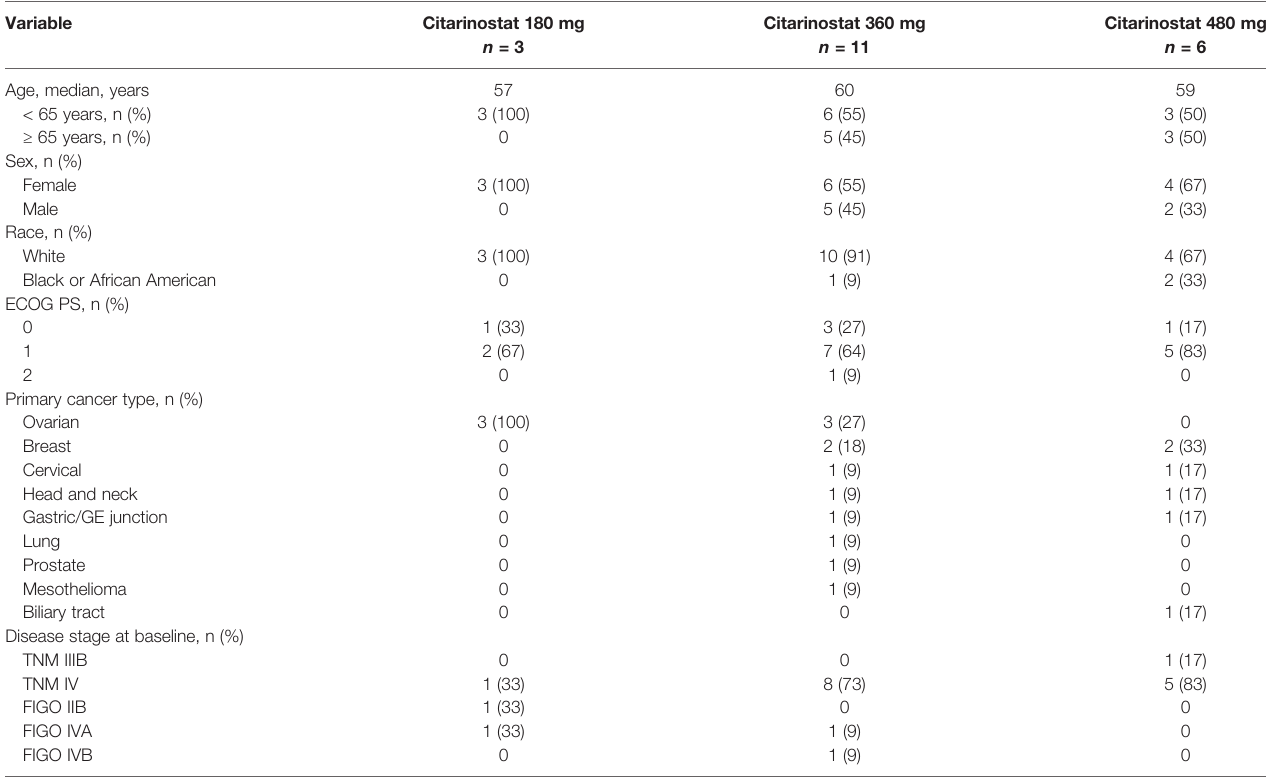
TABLE 2 | Patient demographics and baseline characteristics: safety